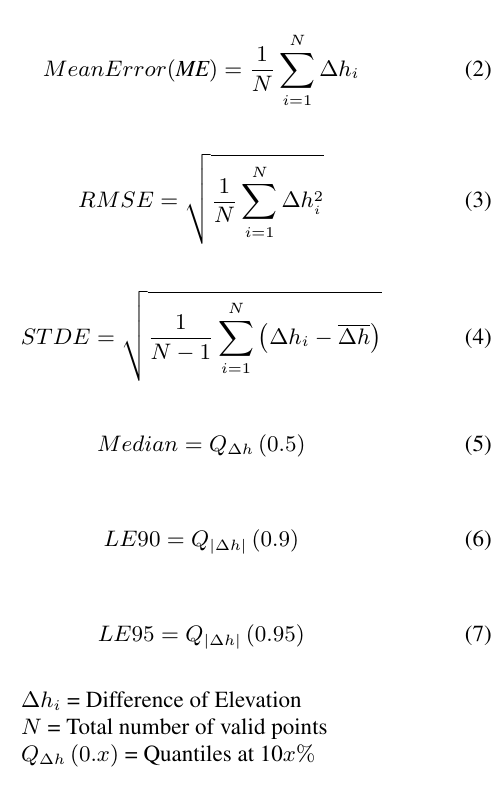
Table 1. Datasets considered for the study, its resolution and available source terms of ME, RMSE, STDE and linear errors LE90 and LE95 (Zhang et al.,